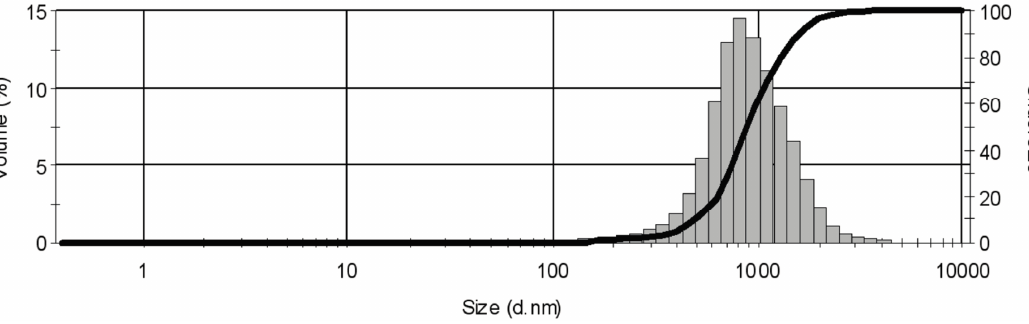
Figure 8. PSD of CuO particles prepared in batch process (Table 1, sample